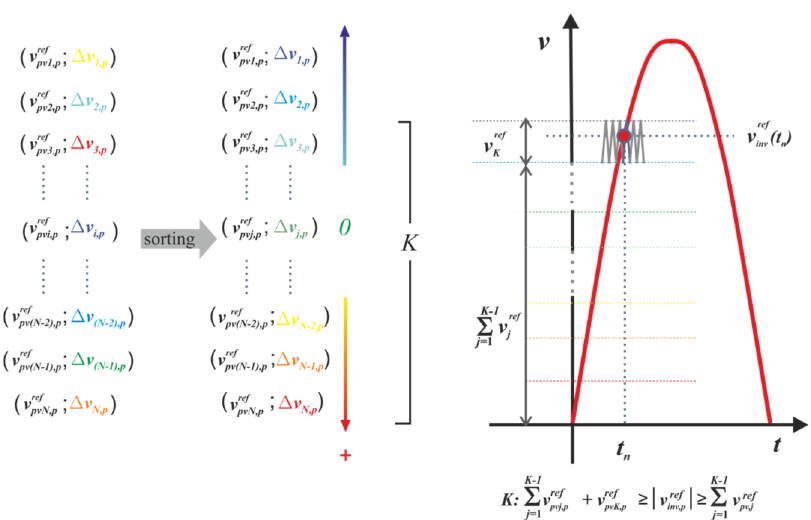
Figure 3. Proposed pulse ‐ width modulation (PWM) technique.